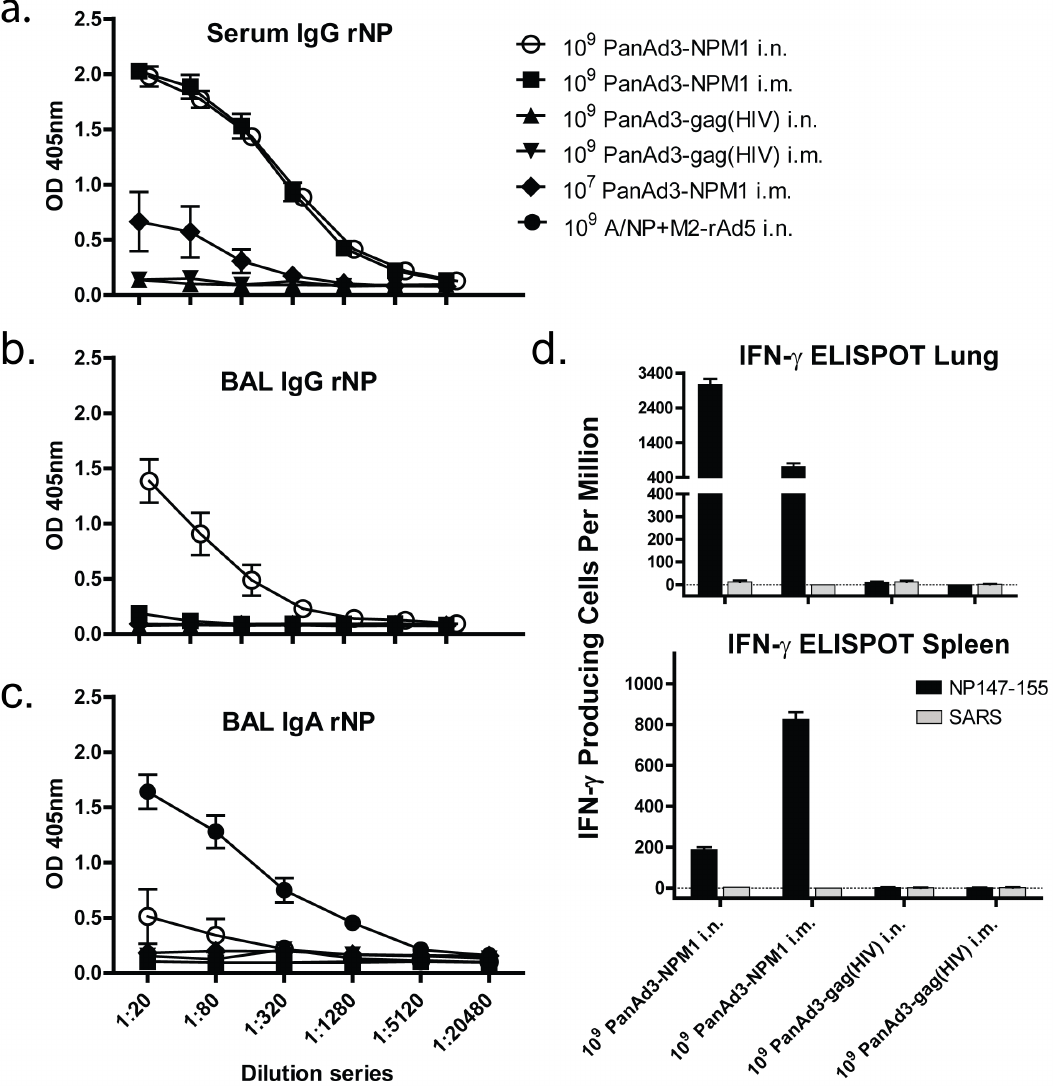
Figure 3. Antibody and T cell responses to PanAd3NPM1. Mice were vaccinated with 10 9 or 10 7 total vp/mouse. Immunizations were by either the i.n. or i.m. route, as indicated. Four weeks later mice were sacrificed, and serum and BAL were collected for antibody analysis. Lung T cells were also collected for IFN- c ELISPOT analysis. Error bars indicate mean 6 SEM. a) ELISA for IgG antibodies to rNP in the serum. b) ELISA for IgG antibodies to rNP in the BAL. c) ELISA for IgA antibodies to rNP in the BAL. d) ELISPOT for IFN- c T cell responses. Results for three mice per group are reported as number of IFN- c secreting cells per 10 6 cells. Black bars, stimulation with NP 147–155 peptide. Gray bars, stimulation with SARS 209–221 peptide. Top: T cells in the lungs. Bottom: T cells in the spleen. Bars show mean 6 SEM of pooled group triplicates, not individual